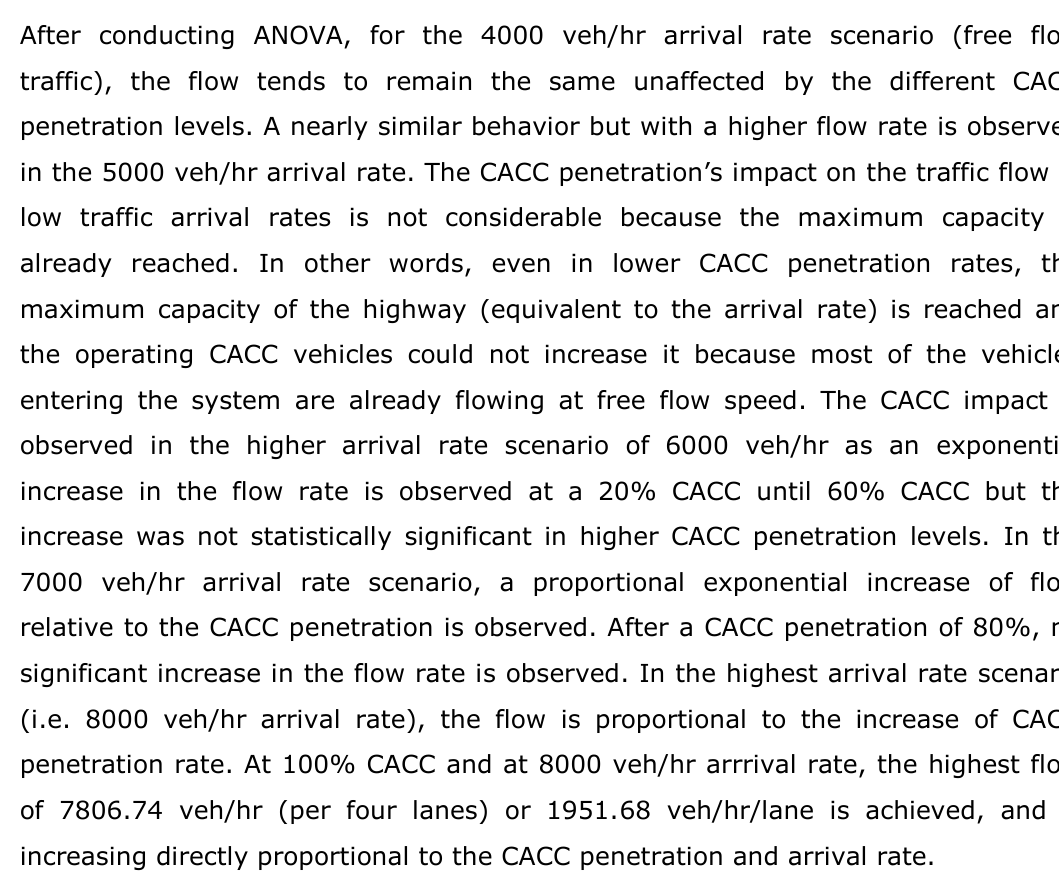
Figure 6. Flow rate analysis (with